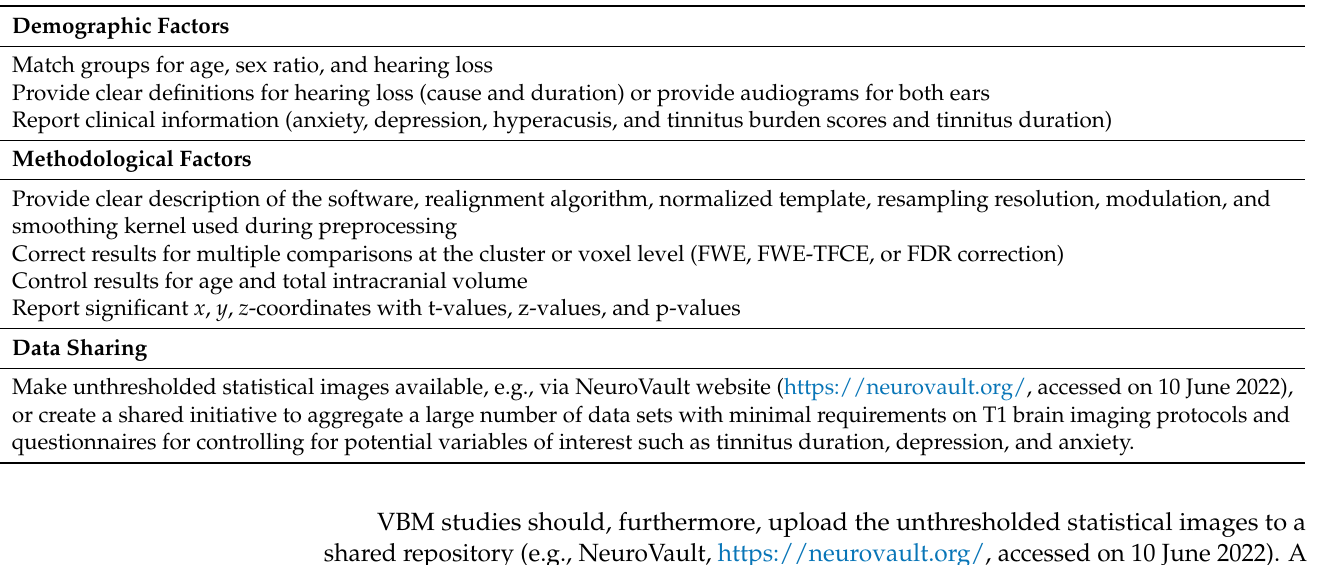
Table 4. Recommendations for future (meta-analyses of) VBM studies investigating